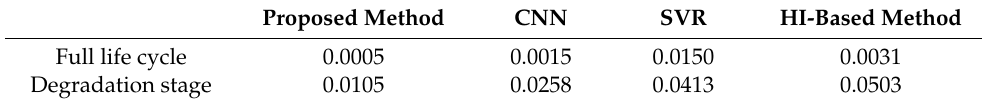
Table 4. MSE of the proposed method, CNN, SVR and the HI-based method in case